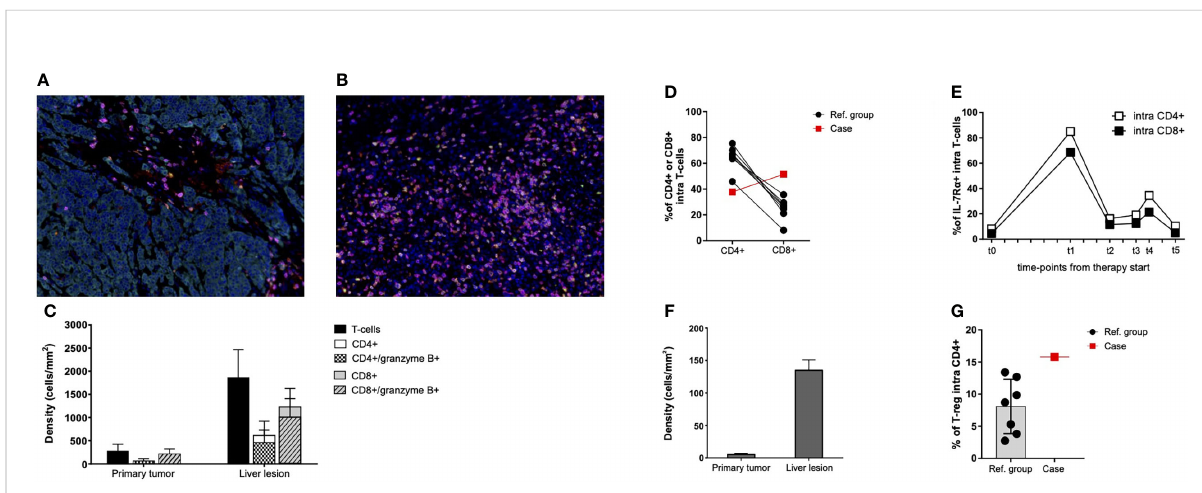
FIGURE 3 T-cell functional state in primary tumor, liver lesion, and PBMCs. (A, B) Representative seven-color mIHC images of T-cell in fi ltrates of PT (A) and LL (B) ; staining antibodies of “ panel 3 ” : CD3 (pink), CD8 (magenta), CD4 (red), granzyme B (yellow), FoxP3 (green), pan-cytokeratin (cyan), and nuclei (blue). Original magni fi cation, ×20. (C) mIHC cell densities of CD4+, CD8+, and granzyme B+ T cells in 10 fi elds of PT and LL samples. Mean values and SD are reported for each cell population. (D) Percentages of CD4+ and CD8+ T cells in fi ltrating fresh liver lesions from the patient (Case; red square) and from the reference group (Ref. group; black dots), as assessed by fl ow cytometry. Data are gated on CD3+ cells. Connected date derived from the same lesion. (E) Percentages of IL-7R – expressing circulating T cells before therapy start (t0) and during treatment (t1 = disease re-staging after four cycles of immunotherapy, t2 = disease re-staging after six cycles of immunotherapy, t3 = disease re-staging after eight cycles of immunotherapy, and t4 = before surgical resection of the liver residual disease), as assessed by fl ow cytometry. Data are gated on CD4+ and CD8+ T cells before the start of immunotherapy. (F) mIHC cell densities of T-regulatory cells (CD3 +/CD4+/FoxP3+) detected in PT and LL samples. Mean values and SD are reported. Data derived from the same 10 fi elds previously considered (C) . (G) Percentages of T-regulatory cells (CD25bright/CD127low) in fi ltrating fresh liver lesions from the patient (Case; red square) and from the reference group (Ref. group; black dots), as assessed by fl ow cytometry. Data are gated on CD4+ T